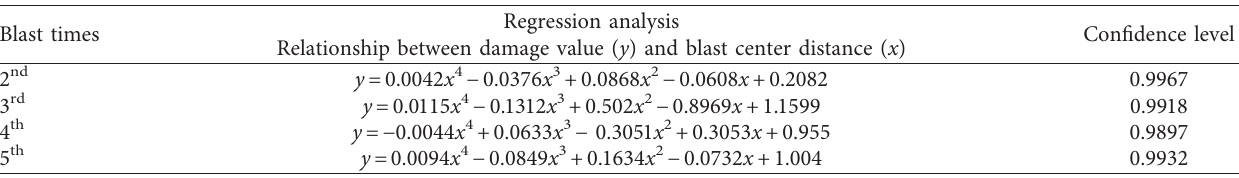
Table 5: The relationship between the damage value of some unit monitoring points of the rock anchor beam along the axis of the powerhouse and the blast center distance.